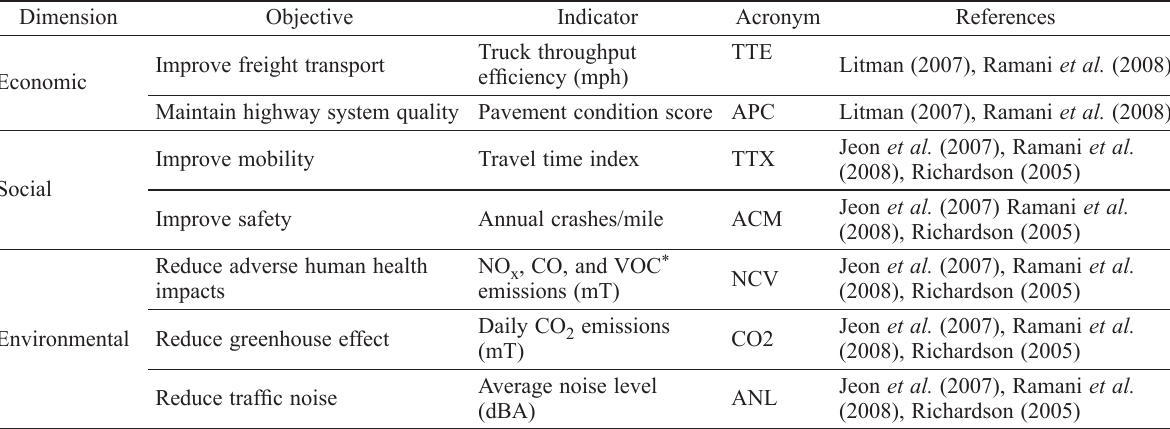
Table 1. Selected highway sustainability objectives and indicators